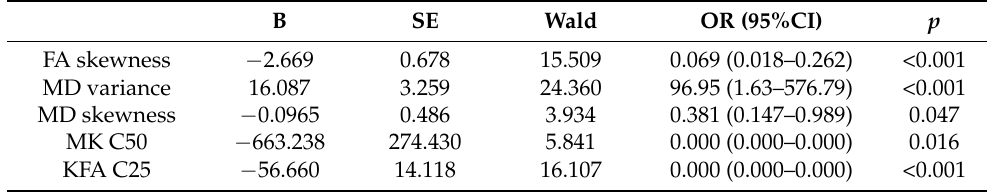
Table 3. The logistic regression analysis of p < 0.05 DKI histogram parameters.